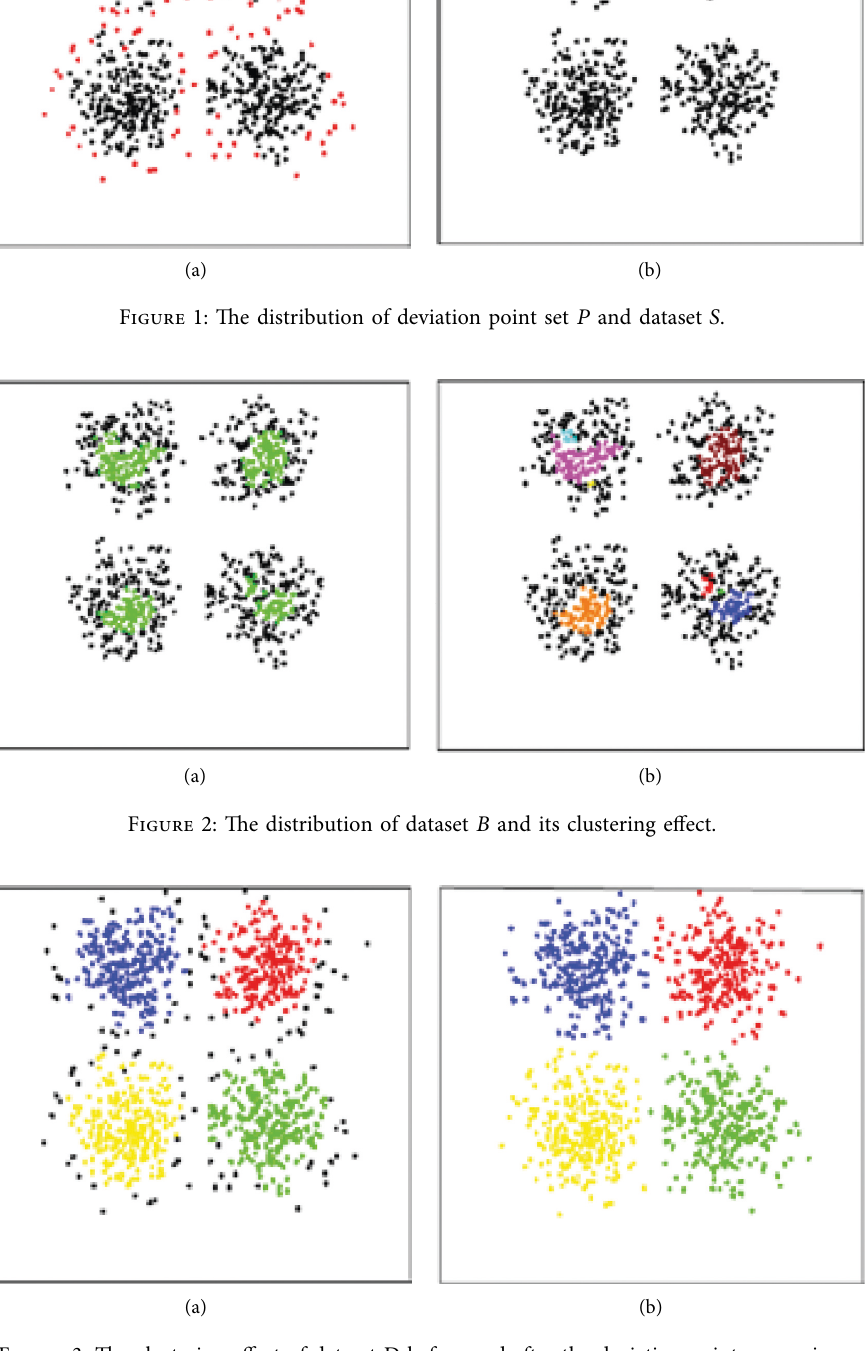
Figure 3: The clustering effect of dataset D before and after the deviation point